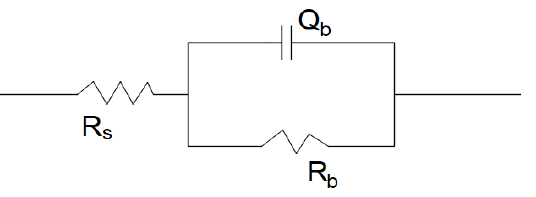
Figure 6. Equivalent circuit diagram of SLM and wrought TiNi sample in ASS.